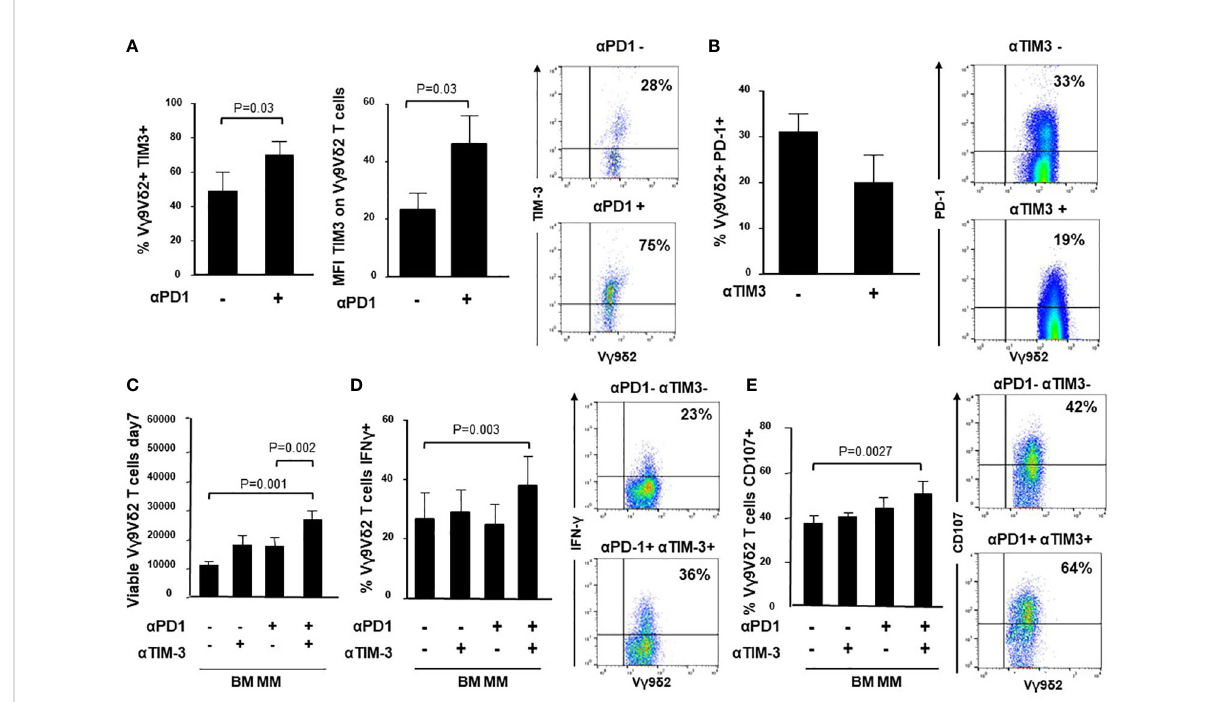
FIGURE 4 Intracellular cross-talk between PD-1 and TIM-3 in BM MM V g 9V d 2 T cells. (A) left: Percentage and MFI of TIM-3+ cells are signi fi cantly up- regulated in BM MM V g 9V d 2 T cells after ZA stimulation in the presence of a PD1. Bars represent mean values ± SE of 6 experiments; right: cyto fl uorimetric analysis of TIM-3 expression after ZA stimulation in the absence (upper panel) or in the presence (lower panel) of a PD-1 in one representative experiment; (B) left: PD-1 expression is slightly down-regulated in BM MM V g 9V d 2 T cells after ZA stimulation in the presence of a TIM-3, but the difference is not statistically signi fi cant. PD-1 expression is signi fi cantly up-regulated after ZA stimulation as already reported in Figure 1B. Bars represent mean values ± SE of 5 experiments; right: cyto fl uorimetric analysis of PD-1 expression after ZA stimulation in the absence (upper panel) or in the presence (lower panel) of a TIM-3 in one representative experiment; (C) ZA-induced BM MM V g 9V d 2 T-cell proliferation in the absence or in the presence of a PD-1, a TIM-3 and the combination thereof. Bars represent mean values ± SEM of 5 experiments. (D) left: intracellular IFN- g production by ZA-stimulated BM MM V g 9V d 2 in the absence or in the presence of a PD-1, a TIM-3 and the combination thereof. Bars represent mean values ± SEM of 4 experiments; right: cyto fl uorimetric analyses of IFN- g production in BM MM V g 9V d 2 T cells after ZA stimulation in the absence (upper panel) or in the presence (lower panel) of dual PD1/TIM-3 blockade. (E) left: CD107 expression in ZA-stimulated BM MM V g 9V d 2 in the absence or in the presence of a PD-1, a TIM-3, and the combination thereof. Bars represent mean values ± SE of 6 experiments; right: cyto fl uorimetric analyses of CD107 expression in BM MM V g 9V d 2 T cells after ZA stimulation in the absence (upper panel) or in the presence (lower panel) of dual blockade PD1/TIM-3